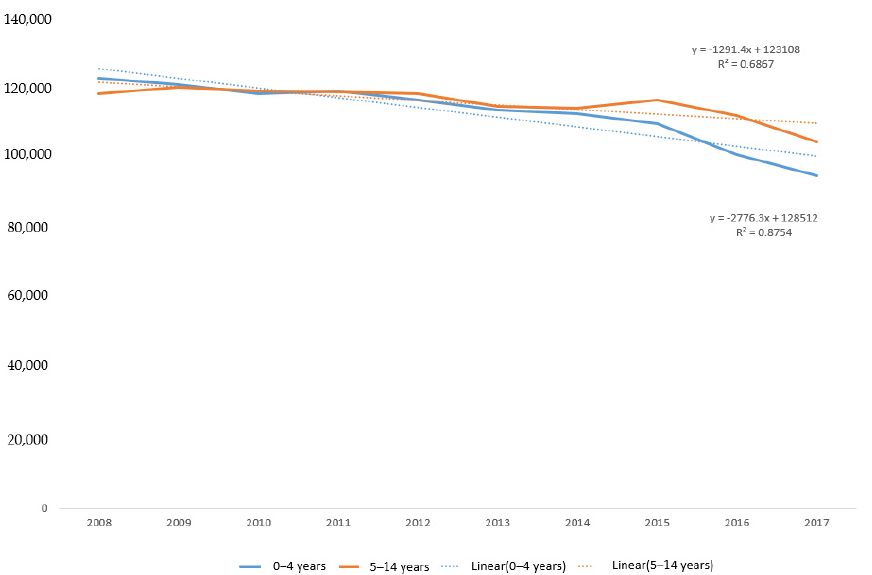
Figure 7. Number of Disability Adjusted Life Years (DALYs) for unintentional drowning and linear trend by age group, children 0–14 years, Philippines, 2008–2017.